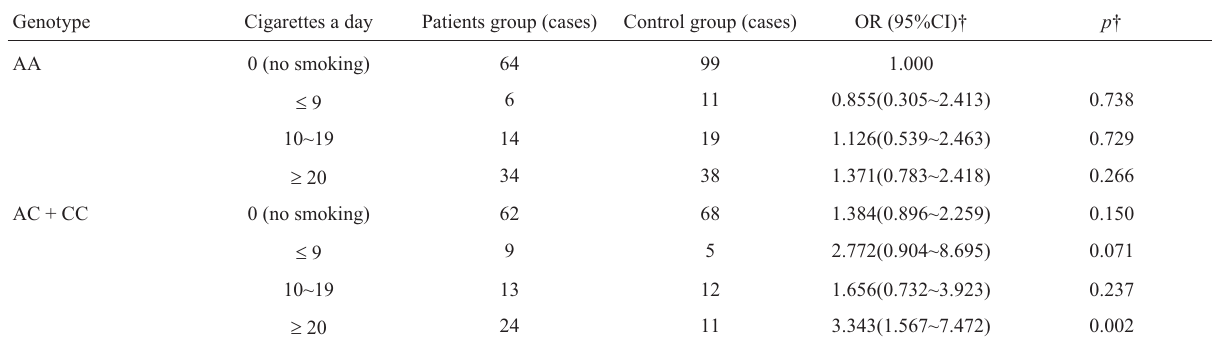
Table 7 - Correlation between daily cigarette amounts a with rs13181-locus polymorphic genotypes and susceptibility of pancreatic cancer.